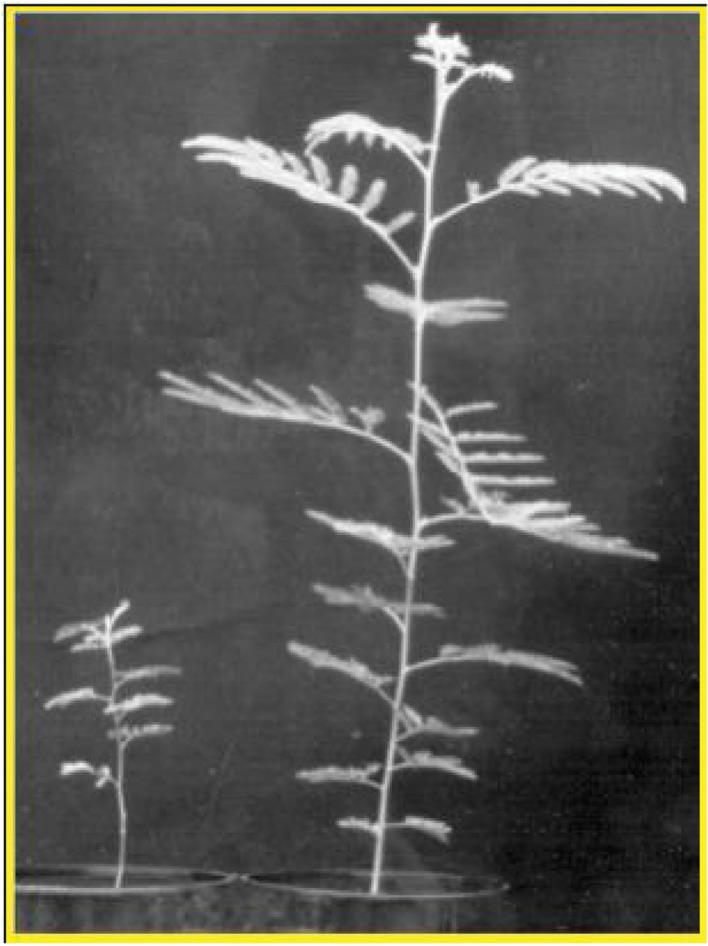
Acacia koa A. Gray grew significantly tall in a low-P soil when inoculated with AM fungus (adopted from Miyasaka et al., 2003).